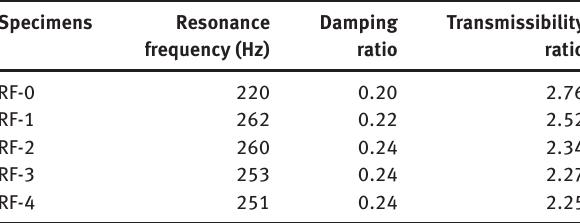
Table 2: The effects of resonance frequency, damping ratio, and transmissibility ratio of CR reinforced with a varying number of polyester tire cord